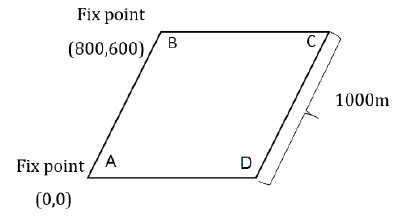
Figure 3. The parallelograms specification.